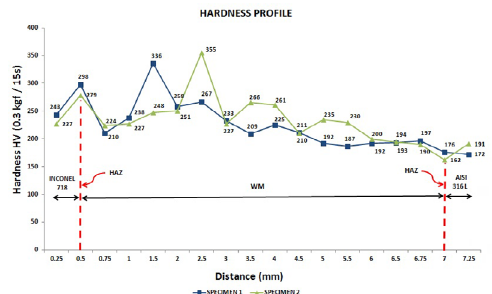
Figure 8. Hardness profile of specimens 1 and 2, along the cross section to the weld bead covering BM, HAZ and